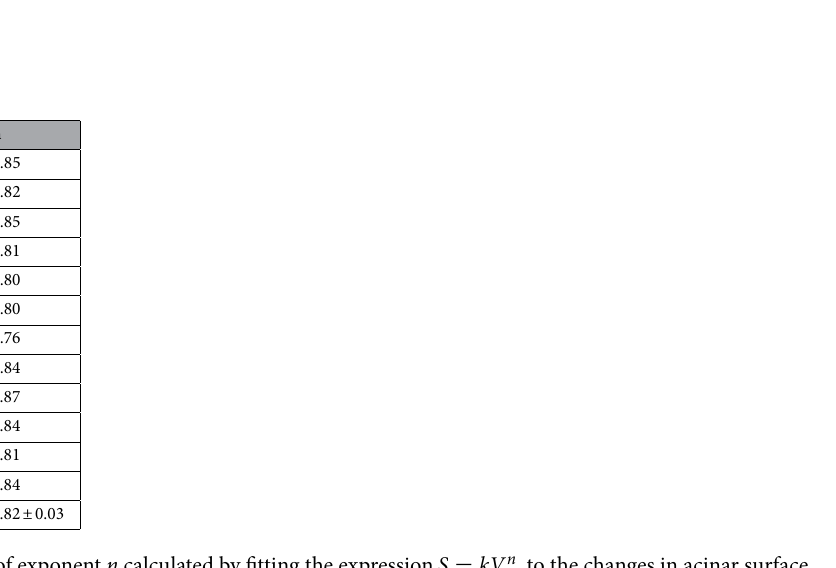
Table 1. Values of exponent n calculated by fitting the expression S = kV area (S) and volume (V) during a positive pressure inspiration from 6 to 12 cmH 2 O. a Region of